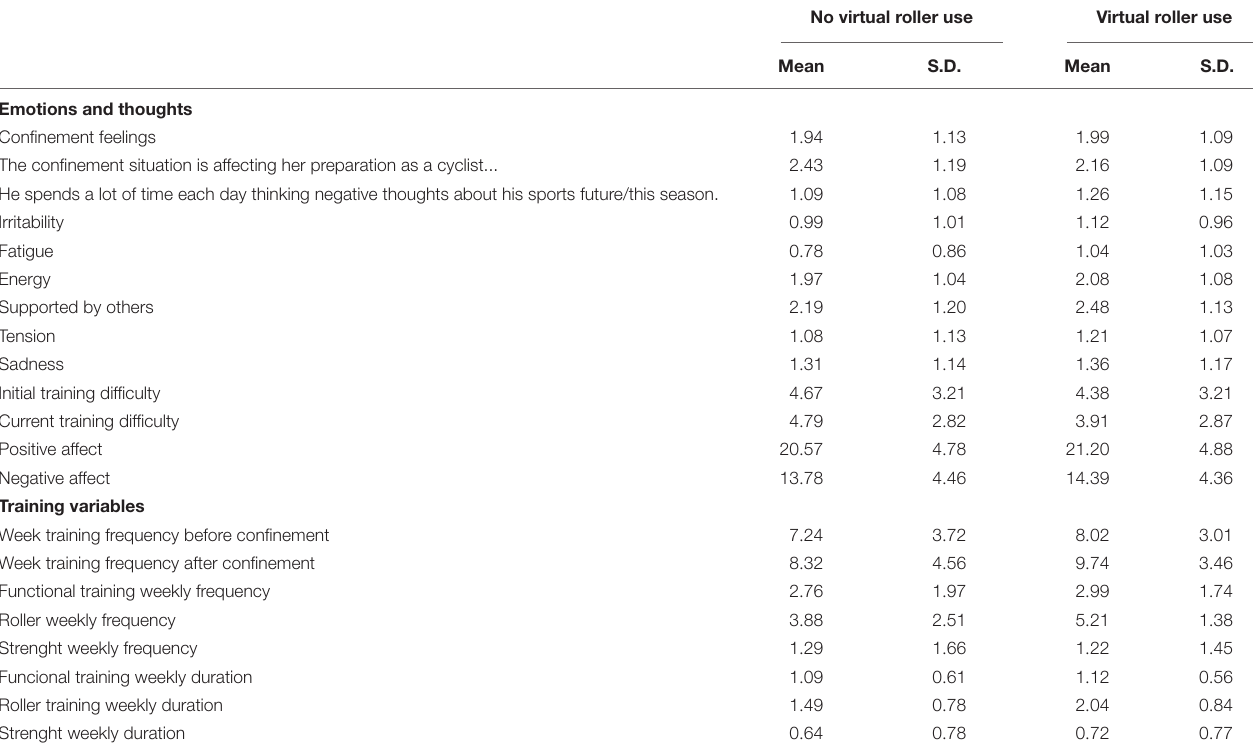
TABLE 3 | Mean and standard deviation (SD) of cyclists that employed (or not) virtual roller during